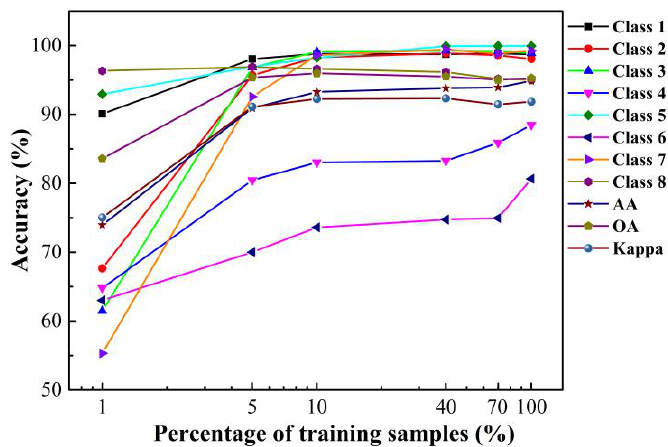
Figure 12. Classification results with varying proportion of training samples.